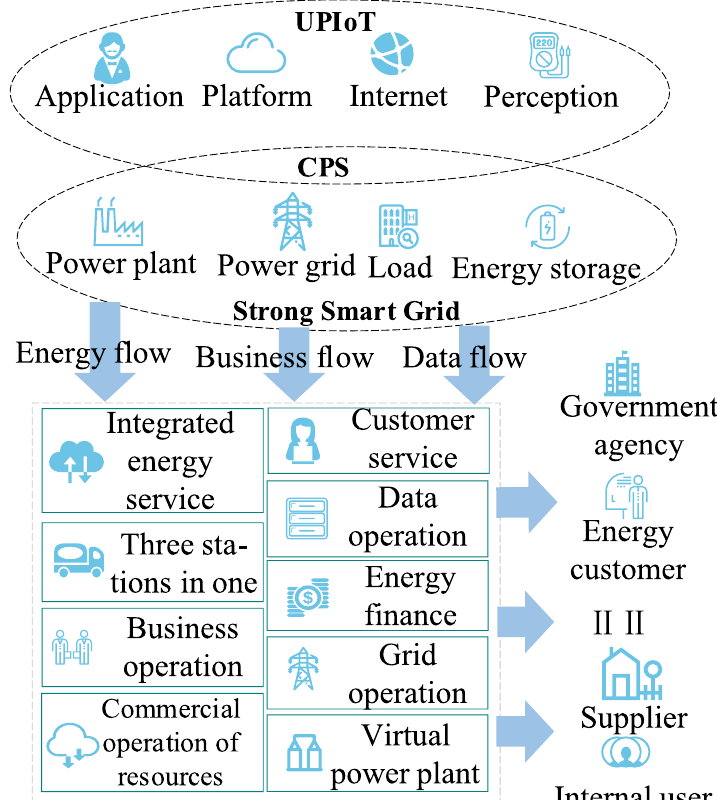
Fig. 2 Framework of the Internet Plus Smart